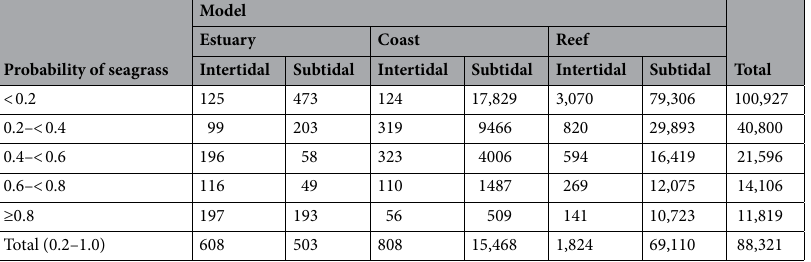
Table 1. Potential seagrass habitat (km 2 ) for each probability class across the Great Barrier Reef World Heritage Area and adjacent estuaries based on six Random Forest models.